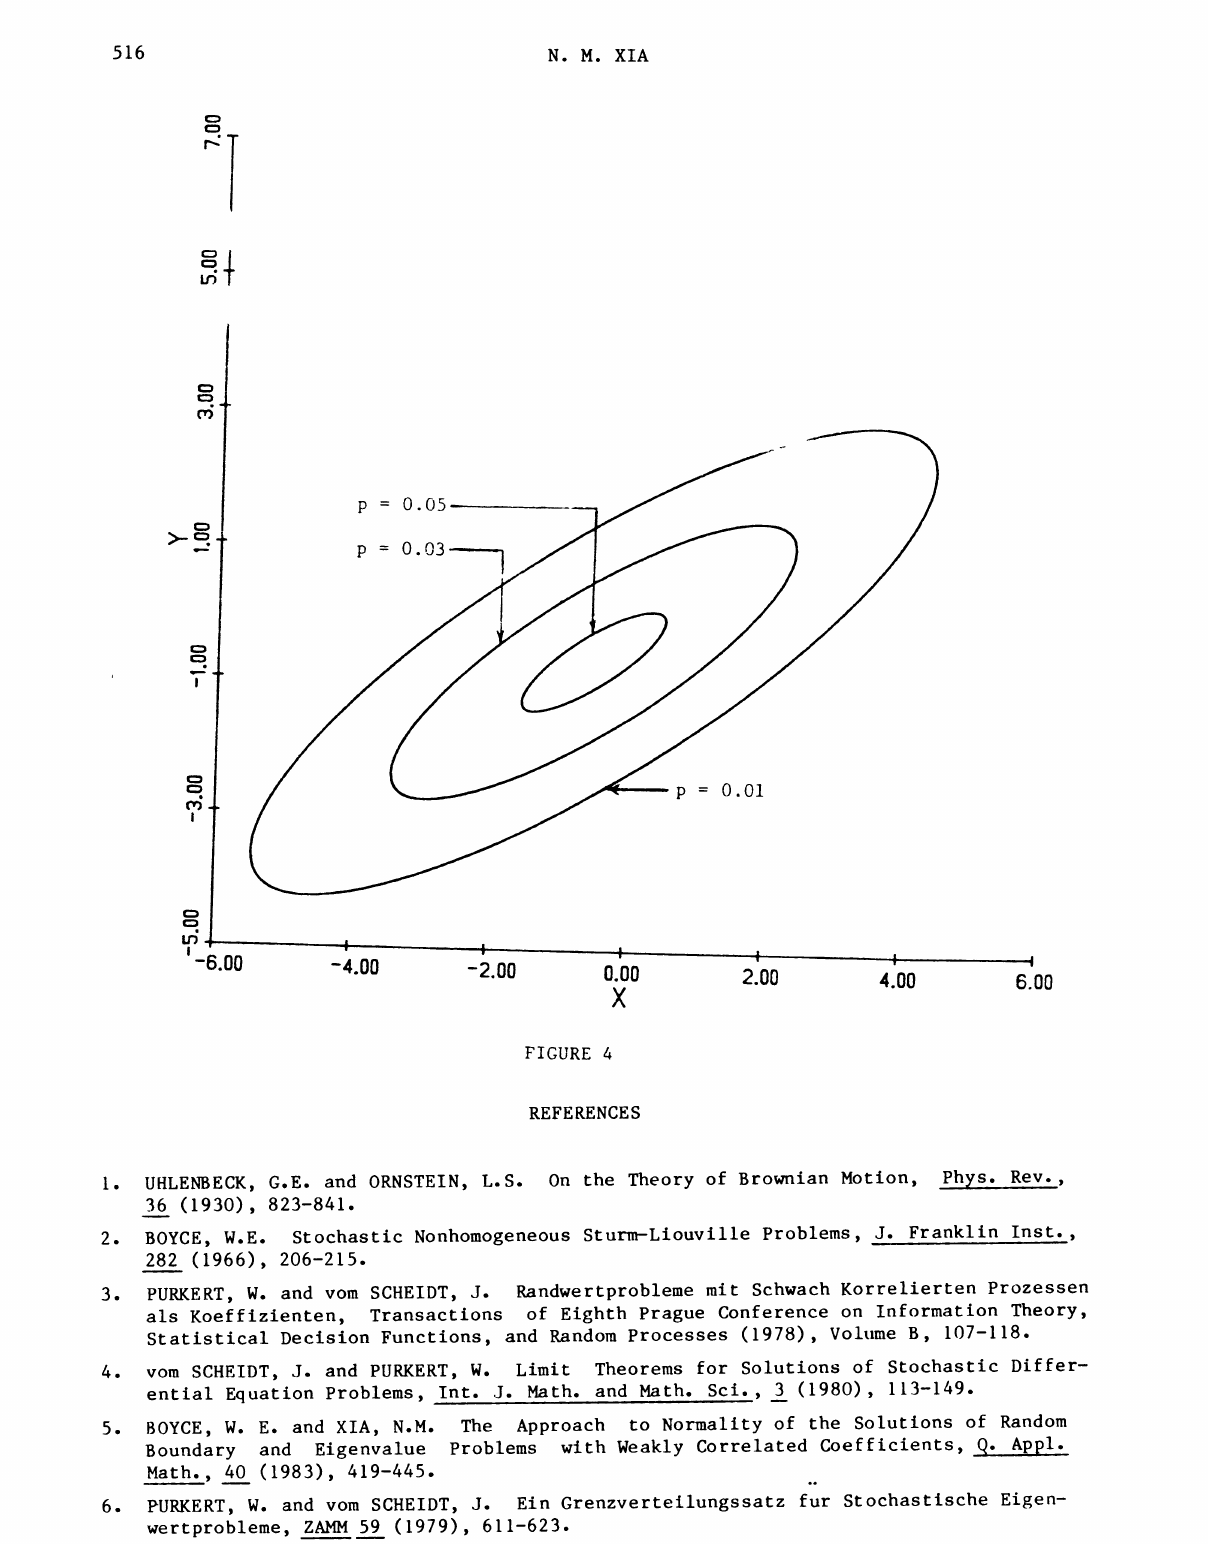
FIGURE 4 REFE RENCE